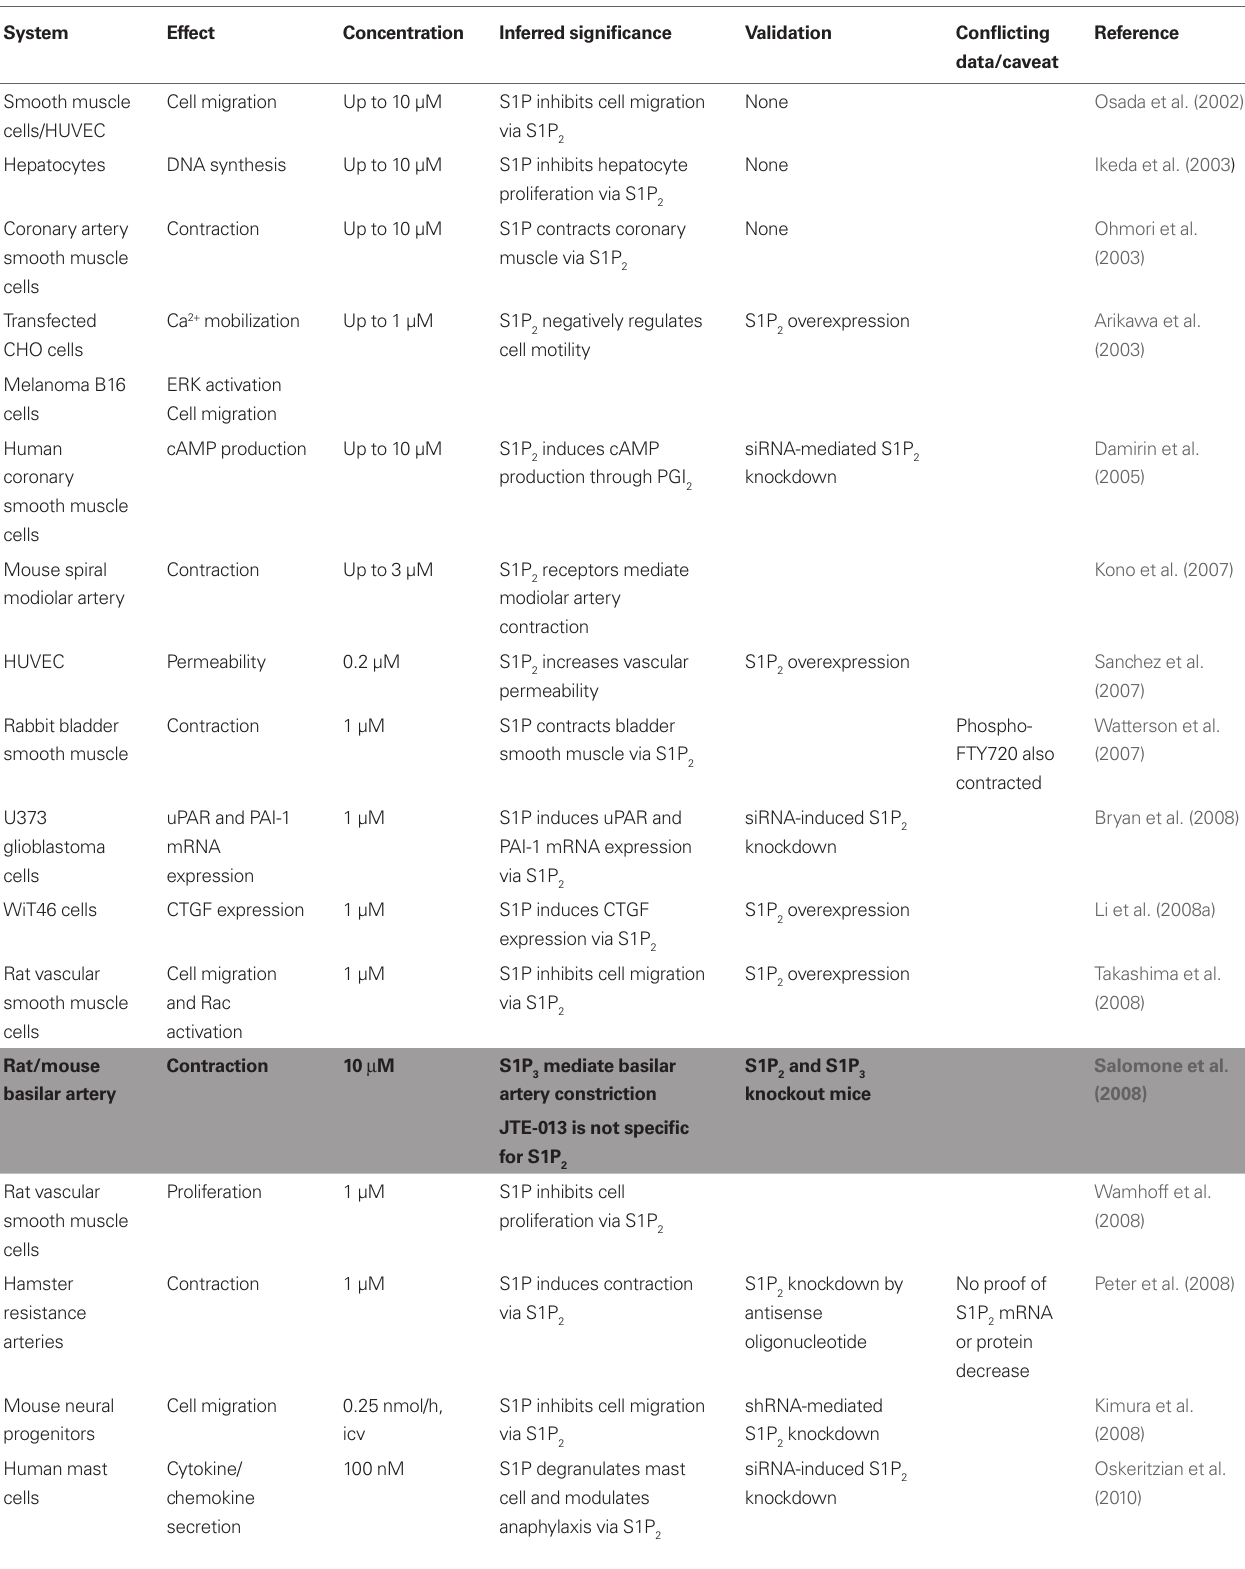
Table 1 | Some published data obtained with JTE-013 (among more than 50 PubMed-indexed citations).